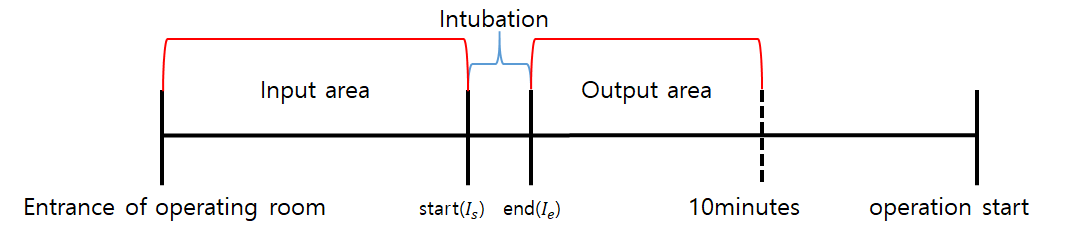
Figure 3. Input and output area based on the intubation